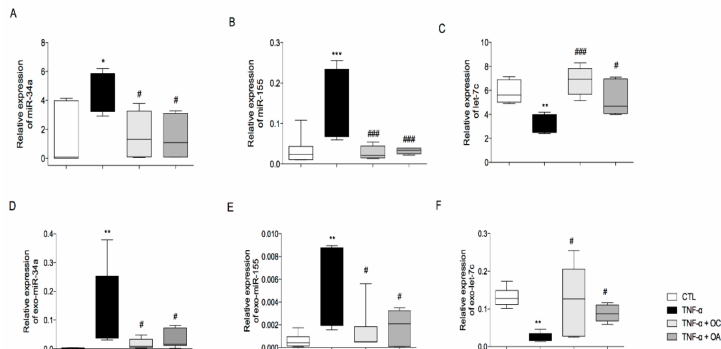
Figure 6. Modulation by OC and OA of TNF- α -induced miRNA expression in adipocytes and in exosomes isolated from conditioned media. SGBS cells were pretreated with OC or OA 25 µ mol / L (6 h) and then stimulated with 10 ng / mL TNF- α for 18 h. Total miRNAs were extracted from cells, and miR-34a-5p ( A ), miR-155-5p ( B ) and let-7c-5p levels ( C ) were measured by qPCR, analysed using the Ct method and normalized to SNORD6 levels. Total miRNAs were extracted from exosomes, and exo-miR-34a ( D ), exo-miR-155 ( E ) and exo-let-7c ( F ) levels were measured by qPCR, analyzed using the Ct method and normalized to Cel-miR-39. Bars represent means ± SD (n = 3). * p < 0.05 versus CTL. ** p < 0.01 versus CTL. *** p < 0.001 versus CTL. # p < 0.05 versus TNF- α . ### p < 0.001 versus TNF- α